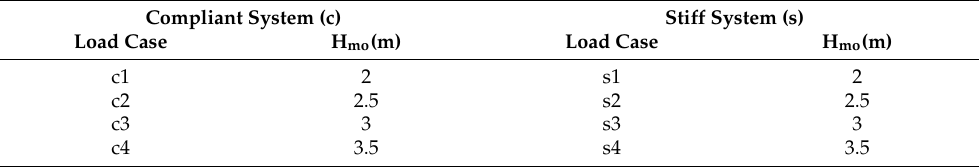
Table 6. Load cases specifications.